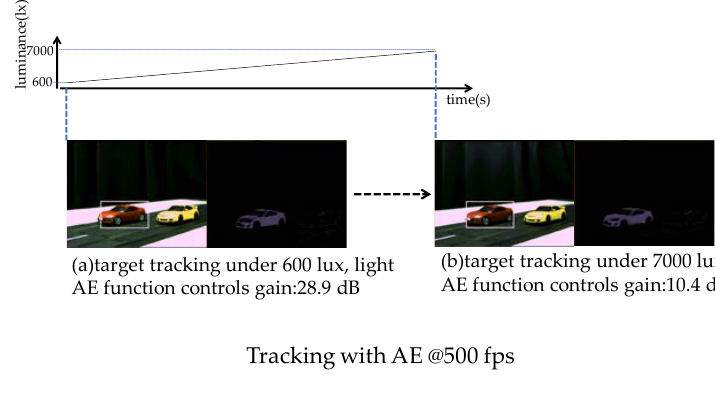
Figure 13. Target tracking with AE/AWB.